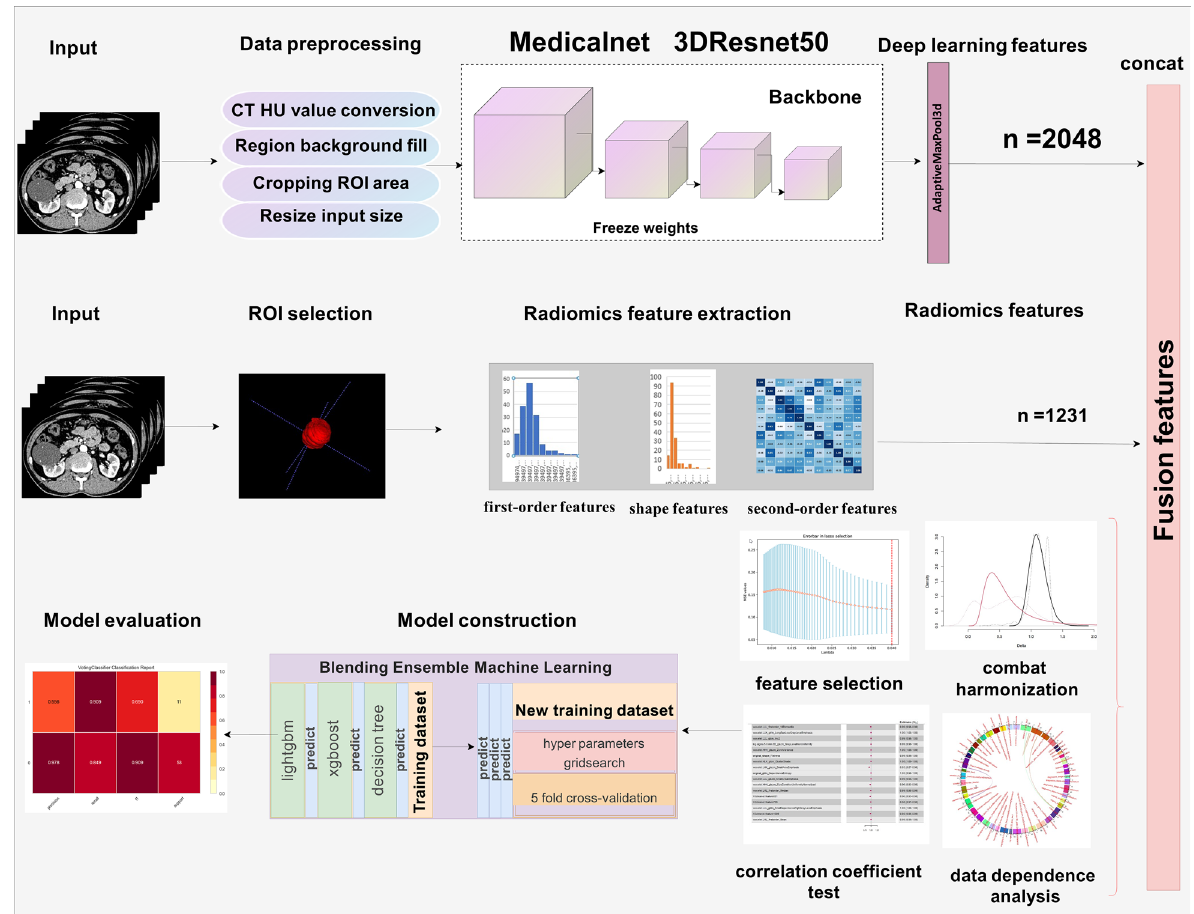
Fig. 3 Flowchart presented the step‑by‑step procedures in machine learning model